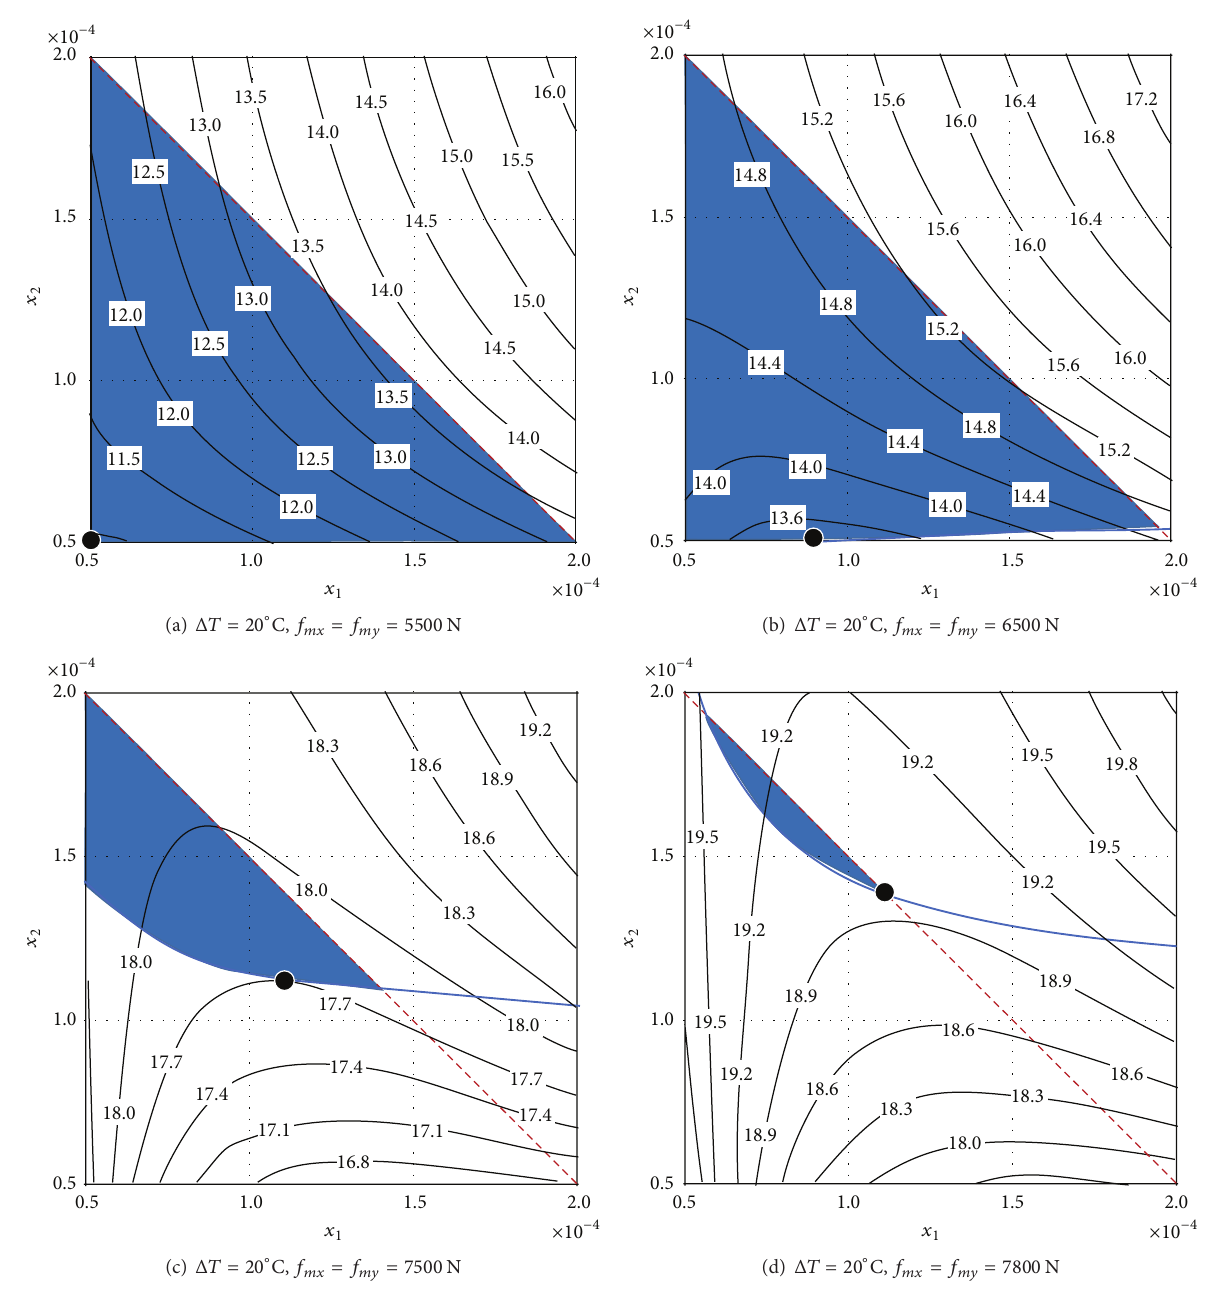
Figure 4: Optimizations under different mechanical